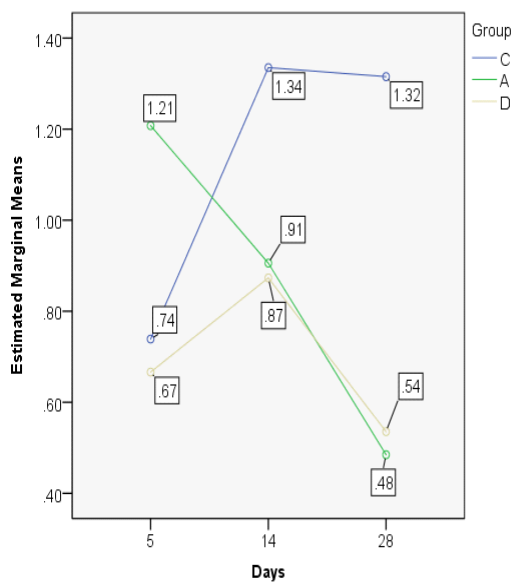
Figure 14. Subepithelial thickness index values, MANOVA test.